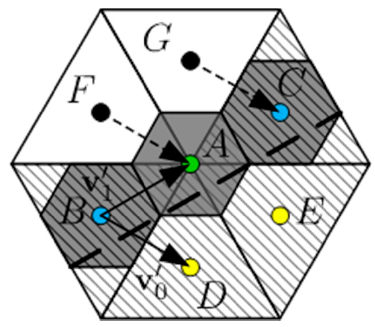
Figure 7. The triangles to which the blue dots correspond have different directions.